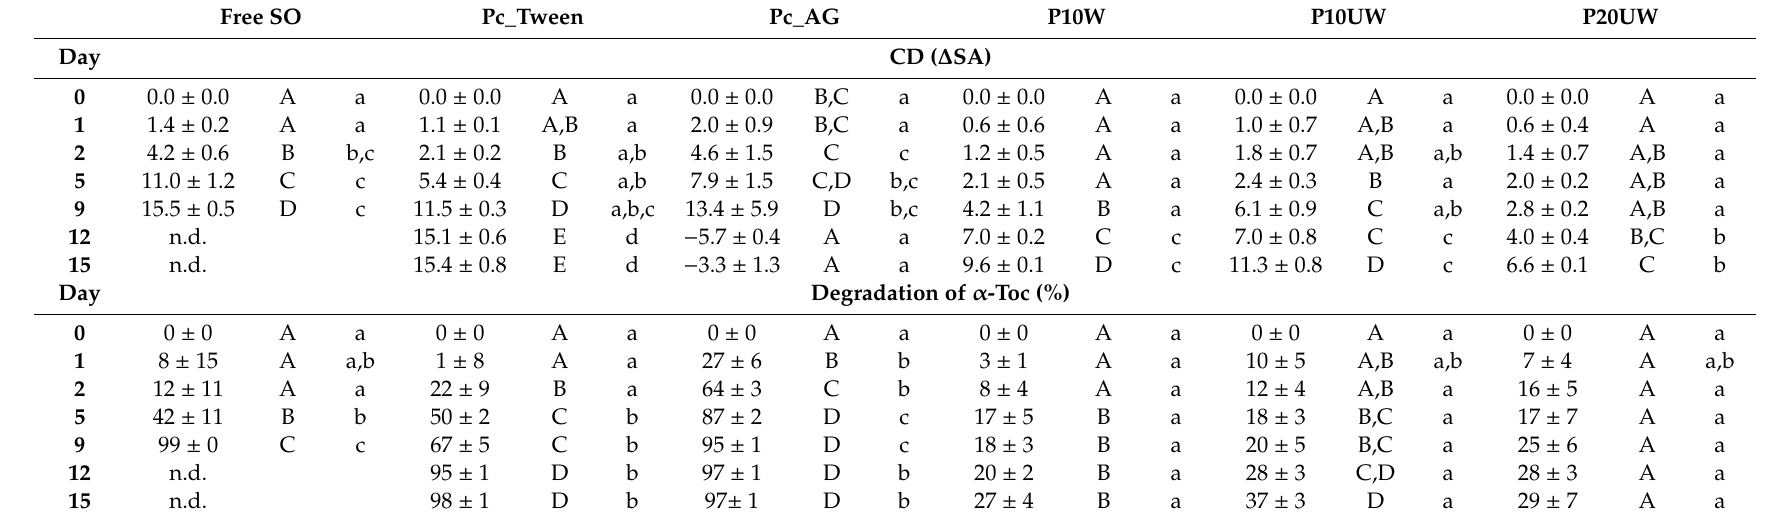
Table 3. CD content and degradation of α -toc in free SO and in powders, determined at di ff erent storage times of up to 15 days. Free